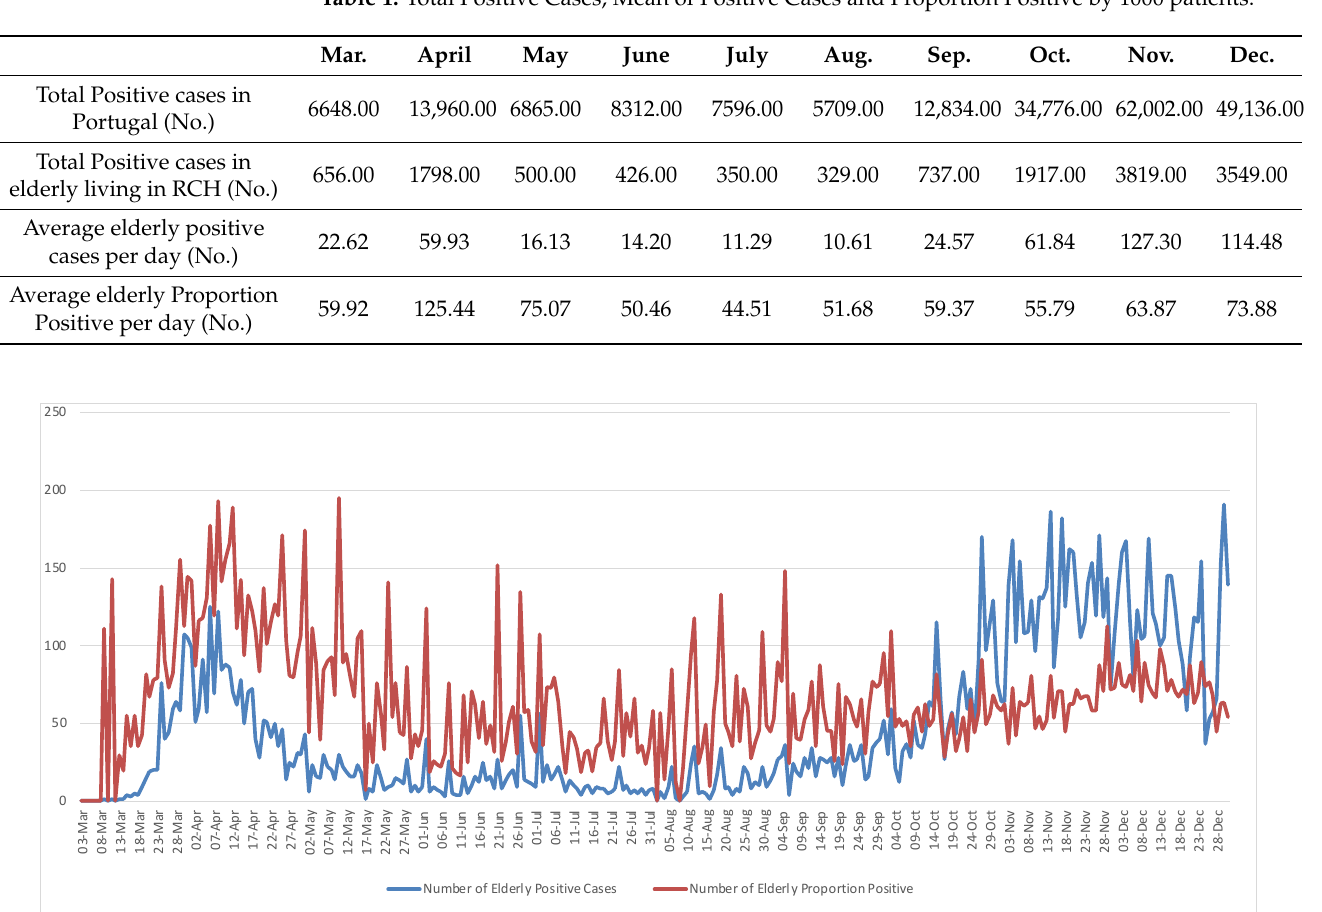
Figure 1. Daily Number of Elderly Positive Cases and Number Proportion Positive. Table 1. Total Positive Cases, Mean of Positive Cases and Proportion Positive by 1000 patients.